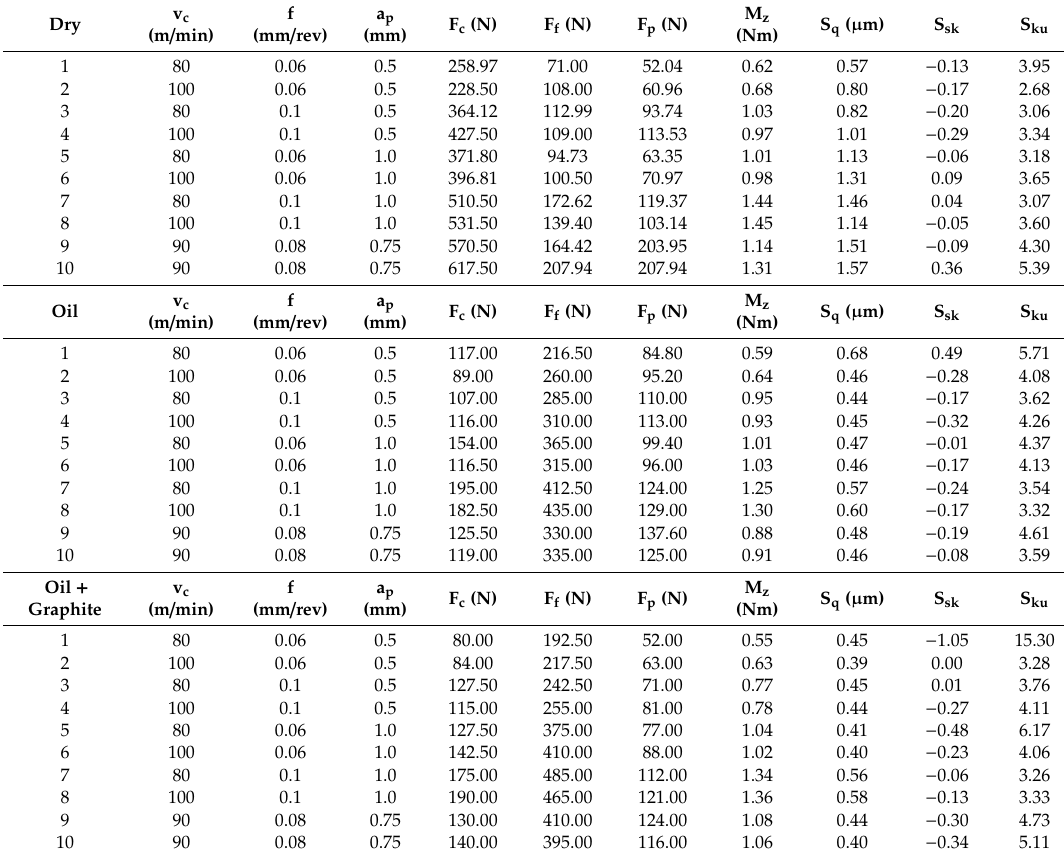
Table 8. Results of factorial design